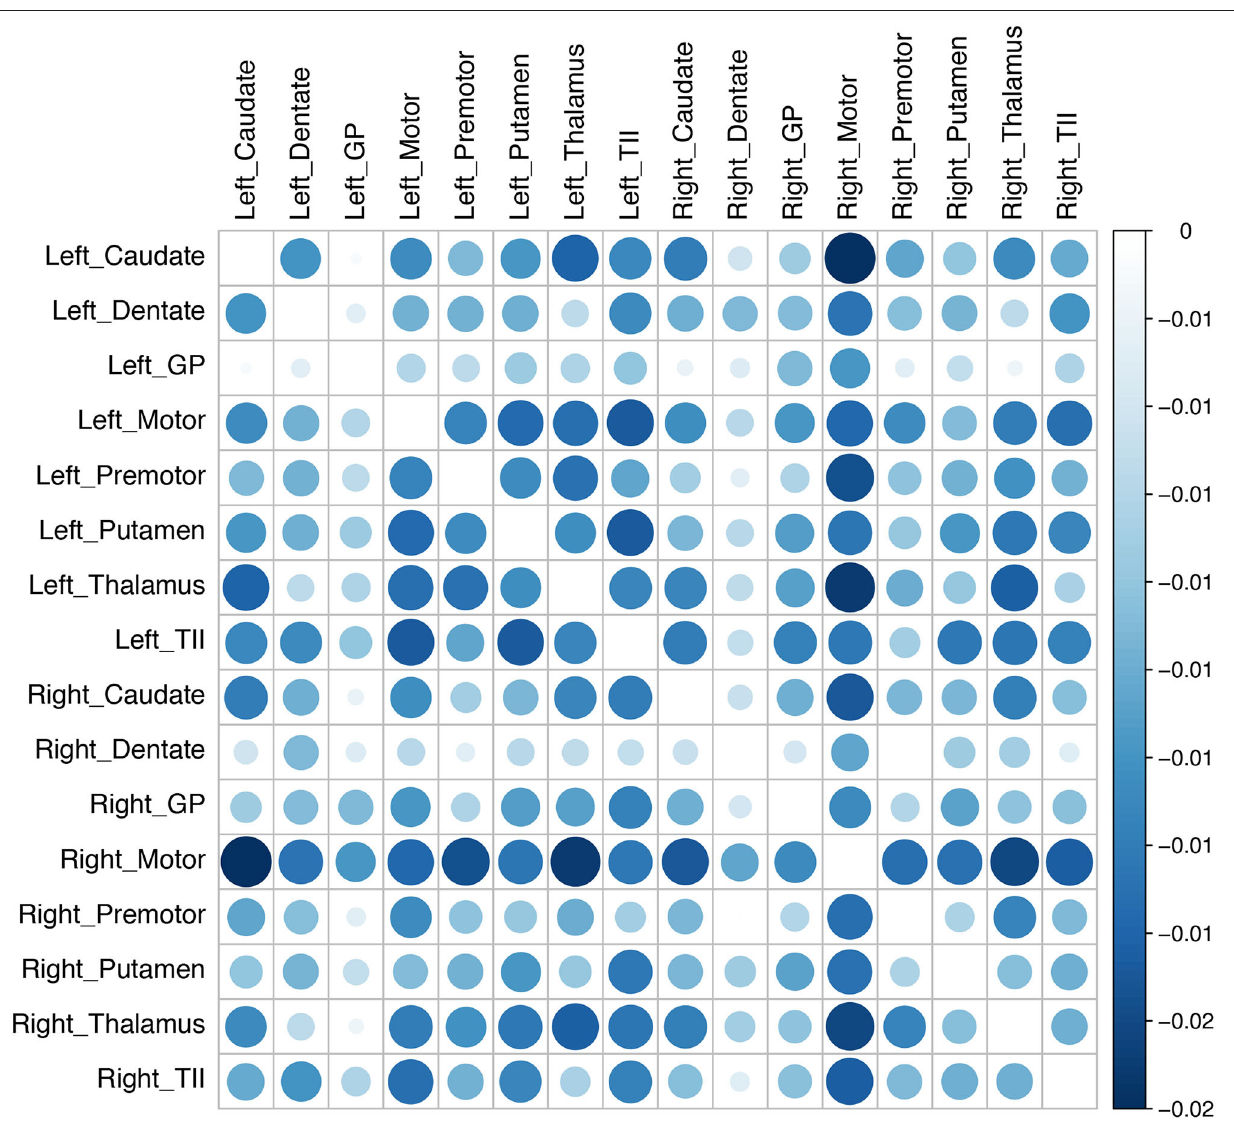
FIGURE 3 | Changes in connectivity in the tremor network after brain cannula insertion. The changes in connectivity are color coded in the matrix (blue implies decline and red implies increase). The magnitude of connectivity change is indicated by the bubble size, while the color intensity represents the statistical significance. There was an overall decline in the tremor network’s connectivity after the canula insertion, although the group-level results did not reach statistical significance (GP, globus pallidus; TII, middle temporal